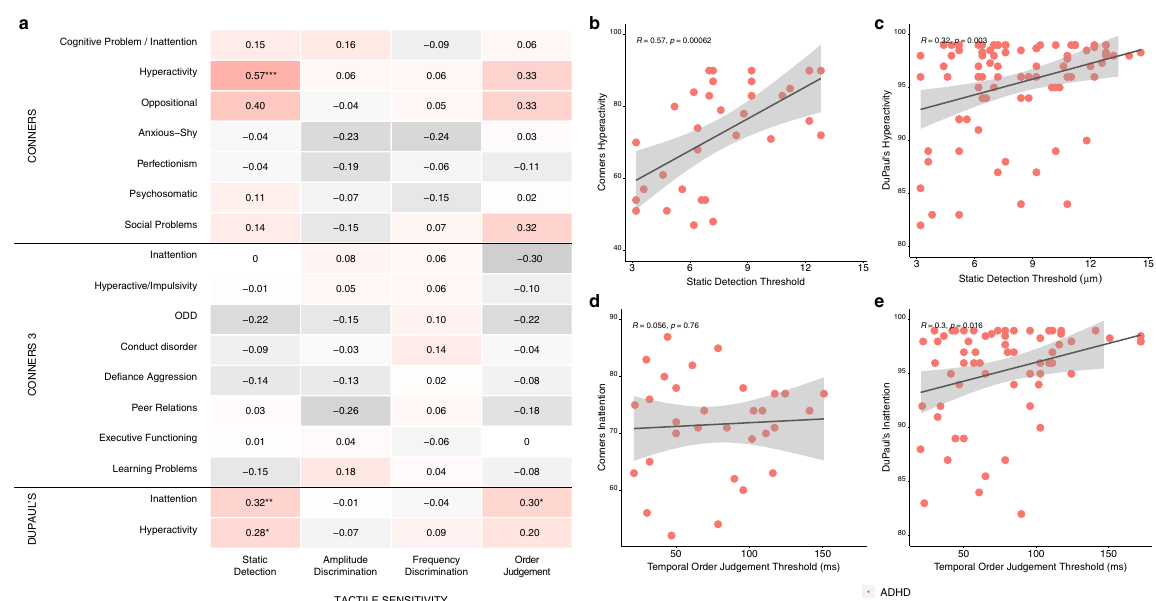
Fig. 8 Correlation analyses between tactile sensitivity thresholds and items from the Conners, Conners 3rd Edition and DuPaul ’ s ADHD rating scales. a Heatmap correlations between subscales of the Conners, Conners 3, and DuPaul ’ s ADHD rating scales ( y -axis) and relevant tactile sensitivity metrics ( x -axis). The “ * ” are used to denote statistical signi fi cance after correcting for multiple correlations using Bonferroni ’ s correction (* p < 0.05, ** p < 0.01, *** p < 0.001). “ t ” was used to denote a non-signi fi cant trend (i.e., p < 0.10). Due to the large number of correlations being conducted, Bonferroni corrections were applied to each of the correlation analyses conducted by multiplying the resulting p -value of each correlation between a given tactile sensitivity metric by the number of subscale items within each questionnaire. After corrections were applied, there were six signi fi cant and two non- signi fi cant trending correlations. We have selectively chosen to highlight the most meaningful correlations as scatterplots presented on the right side. Hyperactivity on the b Conner ’ s and c DuPaul ’ s rating scales correlated signi fi c antly with detection thresholds. Inattention on the d Conner ’ s rating scale was not signi fi cantly correlated to order judgement thresholds, while e DuPaul ’ s rating scales were. See Supplementary Results, Supplementary Fig. 9 for additional correlation analyses. Note that the p -values (* p < 0.05, ** p < 0.01, *** p < 0.001) presented within each scatterplot are the unadjusted p